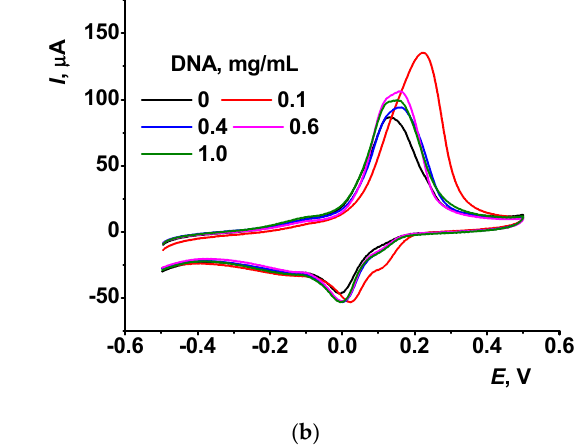
Figure 8. Cyclic voltammograms of 0.5 mM hydroquinone on GCE (1) covered with CB (2), DNA (0.4 mg/mL), with 50 μ M TC and thermally denatured DNA (0.4 mg/mL) with 50 μ M TC. Measure- ments in 0.1 M HEPES, pH = 7.0, 100 mV/s.